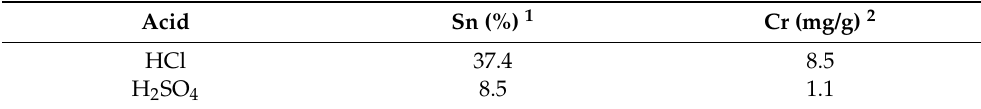
Table 4. Dissolved Sn and Cr in relation to the type of acid used for dissolution (C ads : 10 g/L, m ads /m acid : 1:20, T: 25 ◦ C, t = 30